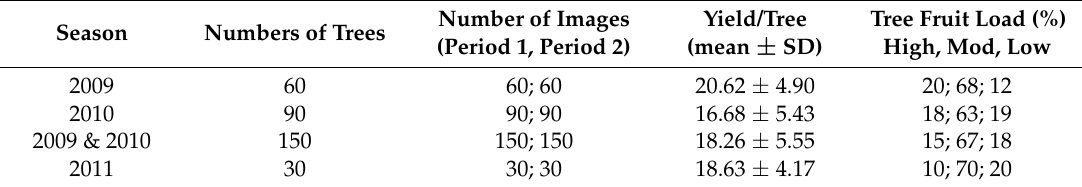
Table 1. Characteristics of samples. Tree fruit load % refers to the % of trees carrying a high (>mean + SD), low (<mean − SD), and moderate fruit load,